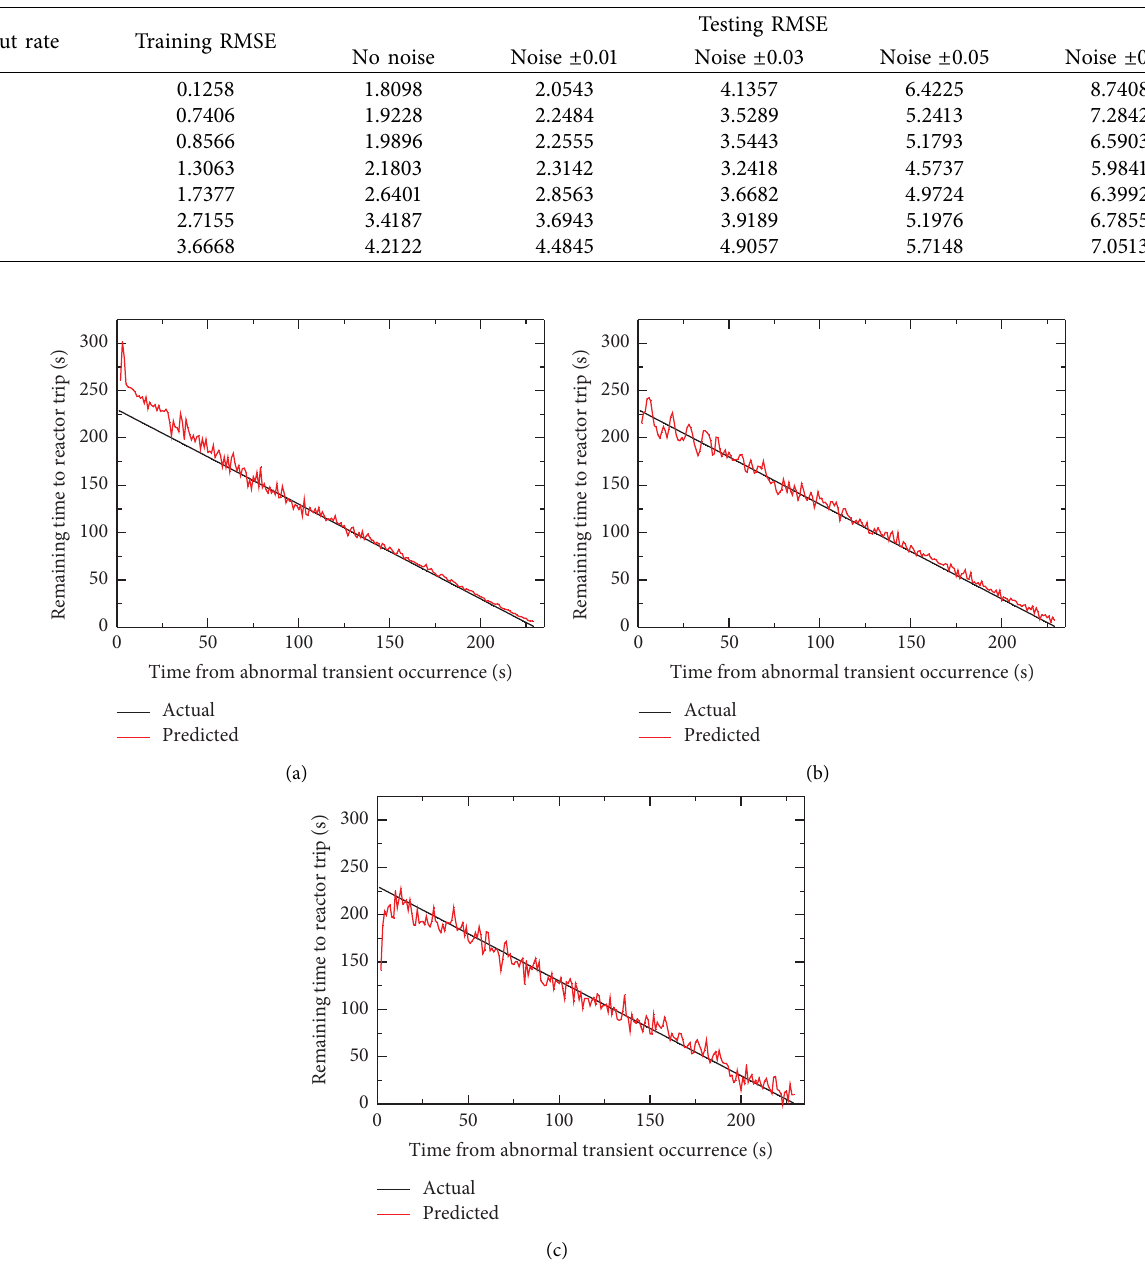
Figure 13: Prediction results for testing data containing artifcial noise (max ± 0.07) by sufciently trained LSTM model with a diferent dropout rate: (a) no dropout; (b) dropout rate � 0.2; (c) dropout rate �